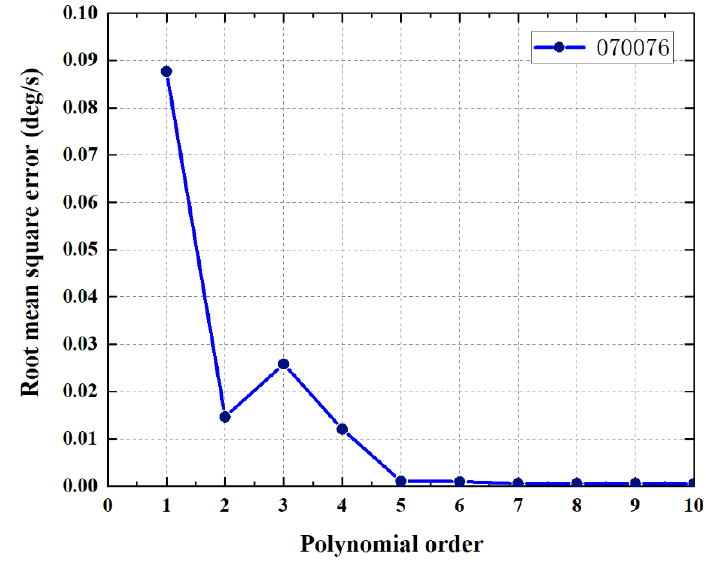
Figure 5. Root-mean-square error vs. polynomial order (070076).